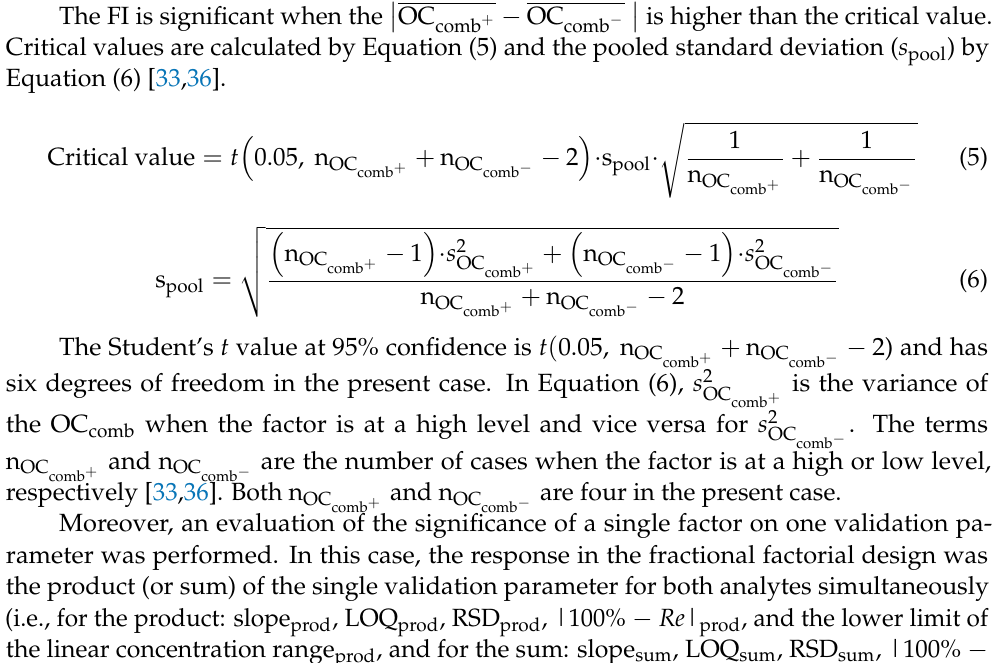
Table 1). LOD, LOQ, linear concentration range, sensitivity, accuracy, and precision were determined. Based on the obtained validation parameter results, OC prod and OC sum values were calculated. The OC prod and OC sum values served as a response for the factorial design. The factor’s impact (FI) on the analytical performance of the BiFGCE was calculated using Equation (4), where OC and OC are the average values of OC prod (or OC sum ) comb + comb − when the factor is at the high and low level, respectively.